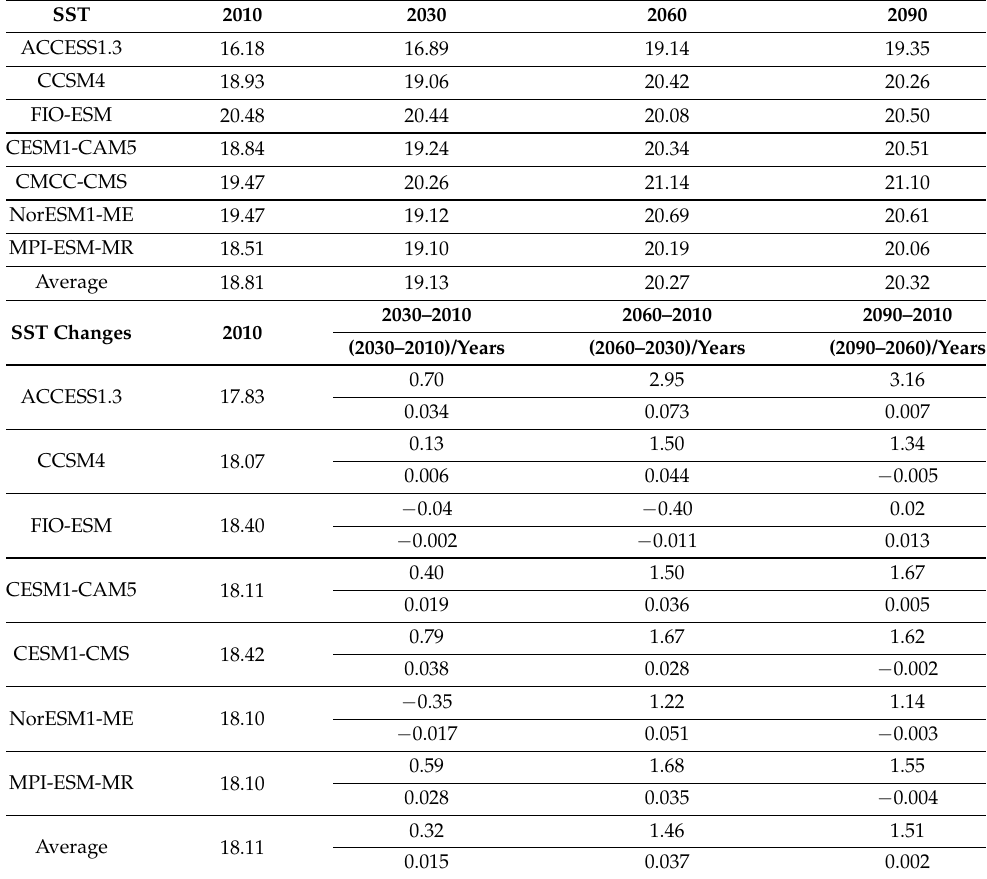
Table A1. The decadal SST variation in the next 100 years using the raw CMIP5 model data without projection result